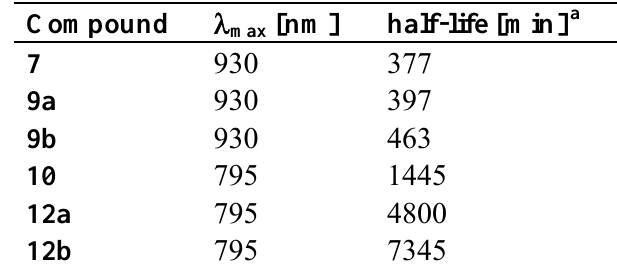
Table 1. Absorption maxima and half-lives of the zwitterionic complexes 7 – 12 in